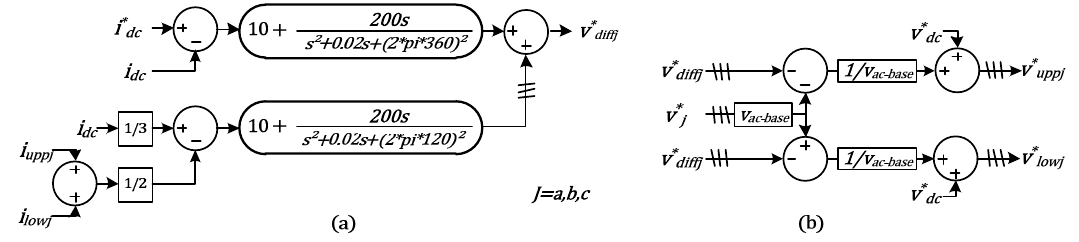
Figure 10. Circulating current control: ( a ) v * diff calculation; ( b ) upper and lower arms voltage reference calculation.